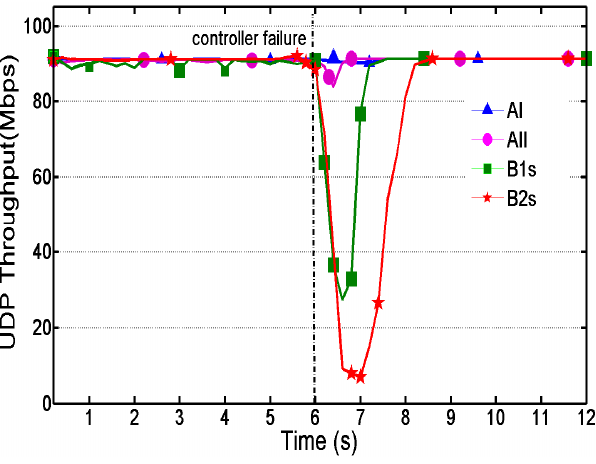
Figure 8. Instant throughput over time.